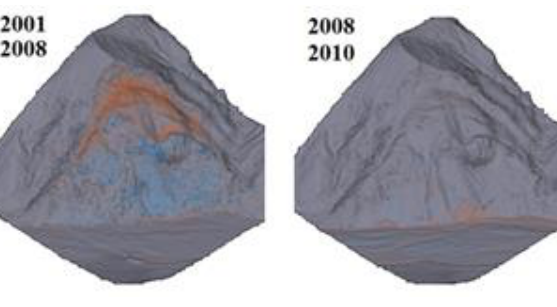
Figure 16: Landslide